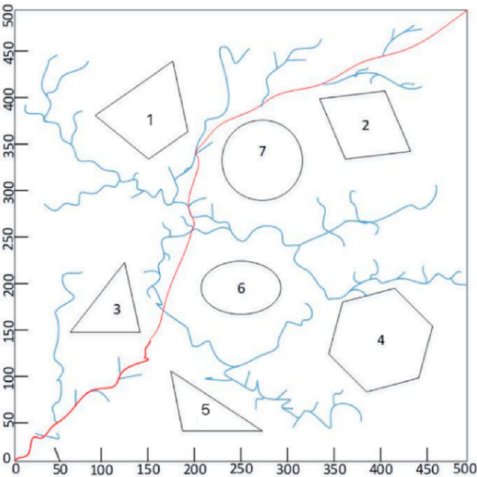
Figure 11. Result of path planning according with kinematical constraint condition.